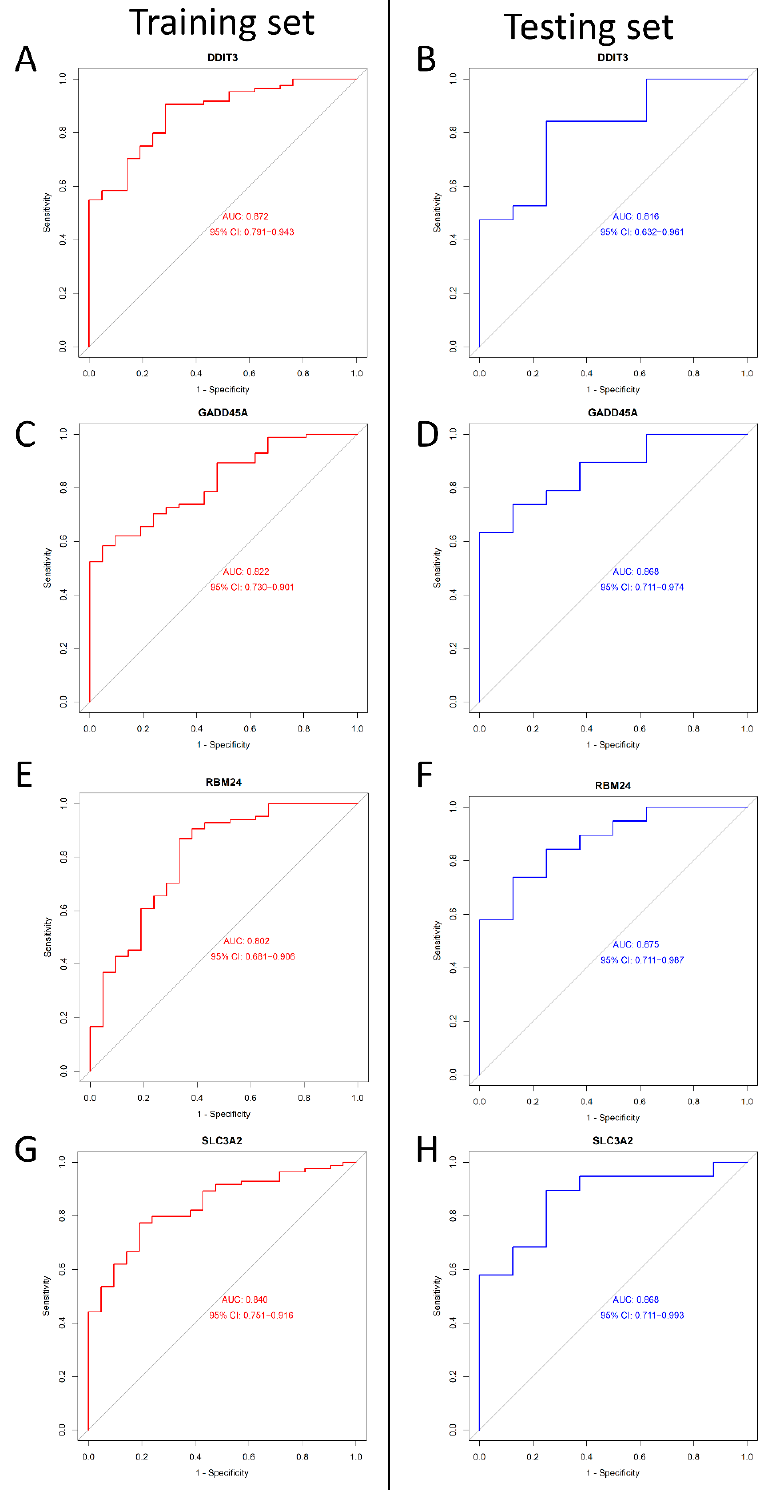
Figure 6. The ROC curves of DDIT3, DDIT3, SLC3A2, and RBM24 between the training and testing groups. ( A ) The ROC curve of DDIT3 in the training group. ( B ) The ROC curve of DDIT3 in the testing group. ( C ) The ROC curve of GADD45A in the training group. ( D ) The ROC curve of GADD45A in the testing group. ( E ) The ROC curve of RBM24 in training group. ( F ) The ROC curve of RBM24 in the testing group. ( G ) The ROC curve of SLC3A2 in training group. ( H ) The ROC curve of SLC3A2 in the testing group. Red represents training, and blue represents